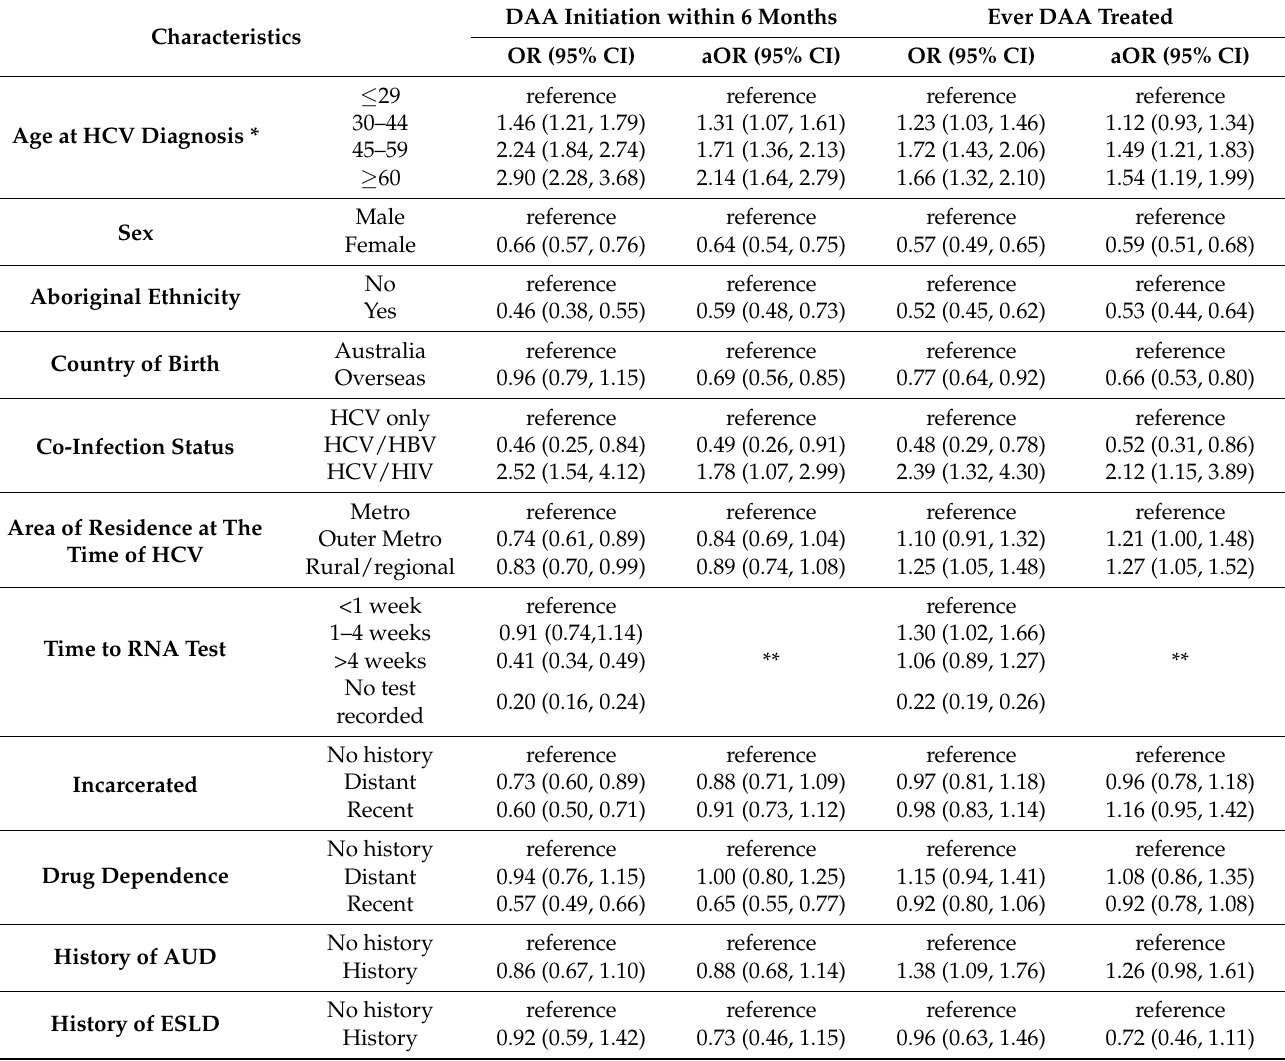
Table 4. Univariate and multivariate logistic regression analysis showing factors associated timely (within 6 months of HCV notification) and ever DAA-treated among people with an HCV notification in NSW 2016–2018 (N = 3925).